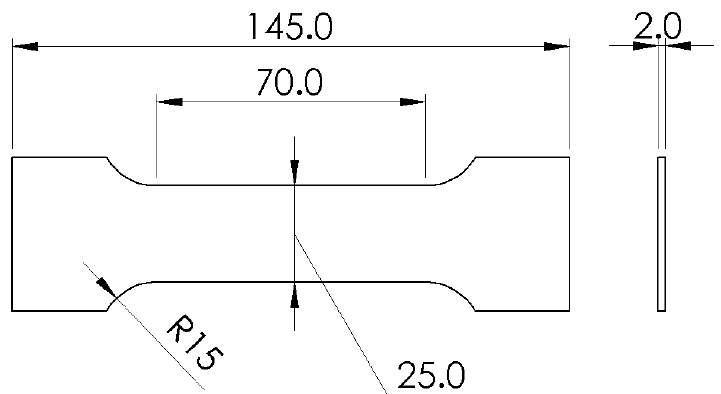
Figure 3. Flat plate specimen geometry. (dimensions in mm)